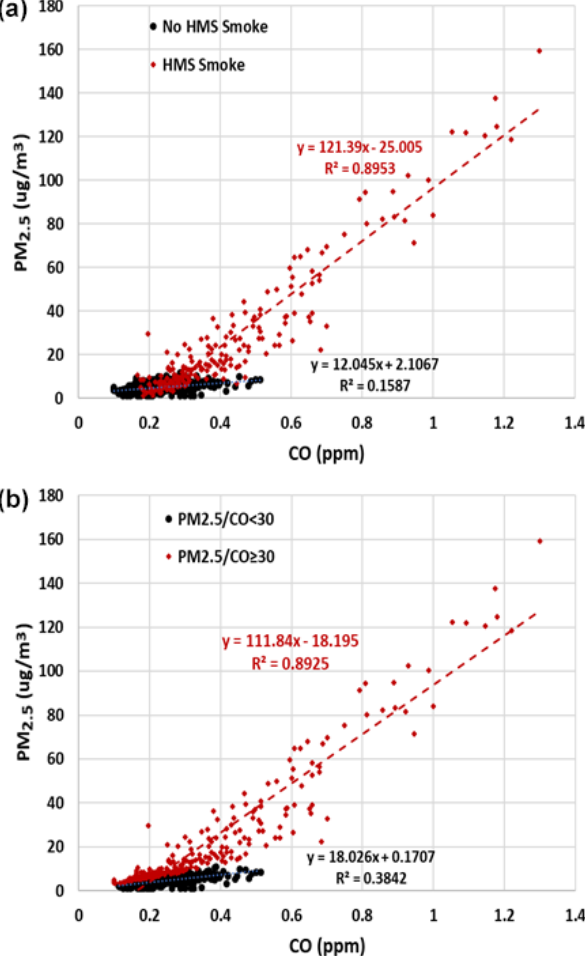
Figure 2. Observed PM 2 . 5 vs. CO for May–September data (1 May 2018–31 August 2021). Each point is the daily mean of observed values segregated by (a) overhead HMS smoke product or (b) PM 2 . 5 / CO threshold of 30.0µgm − 3 ppm − 1